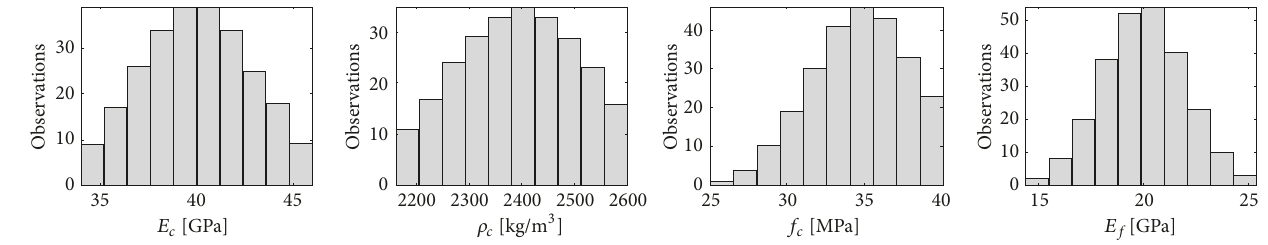
Figure 13: LHS-based sampling for validation of